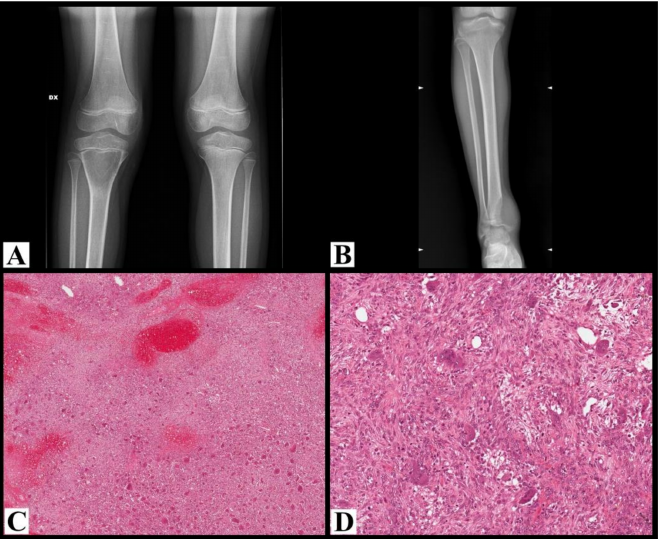
Figure 2. ( A ) Plane X-ray of the knee shows a purely lytic, centrally located lesion in the proximal metaphysis of the tibia with relatively well-defined margins underneath an immature growth